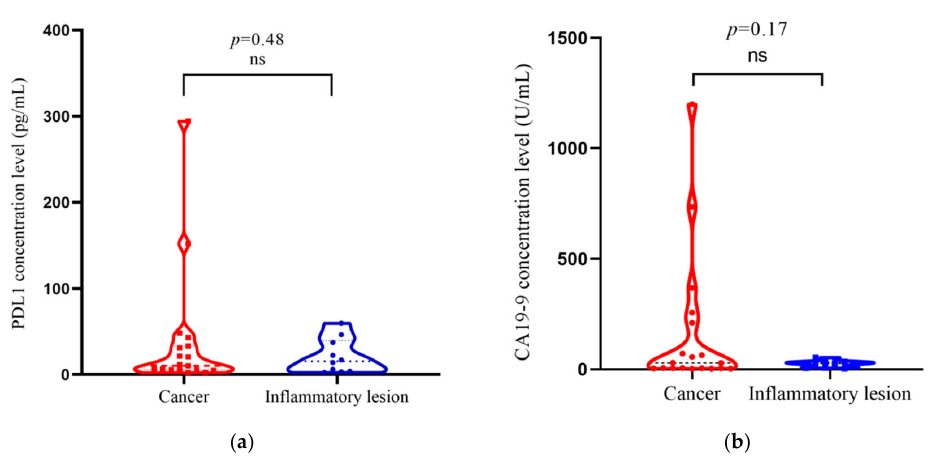
Figure 1. ( a ) Box violin plot shows PDL1 concentration (pg/mL) level in cancer cases ( n = 19) and inflammatory lesions ( n = 10), ( p = 0.48); The red color dot represents PDL1 concentration level in individual cancer cases and blue color dot represents PDL1 concentration in individual inflammatory cases of gallbladder. ( b ) Box violin plot shows CA19 ‐ 9 concentration (U/mL) level in cancer cases ( n = 19) and inflammatory lesions ( n = 10), ( p = 0.13). Red color dot represents CA19 ‐ 9 concentration level in individual cancer cases and blue color dot represents CA19 ‐ 9 concentration level in individual inflammatory cases of gallbladder.